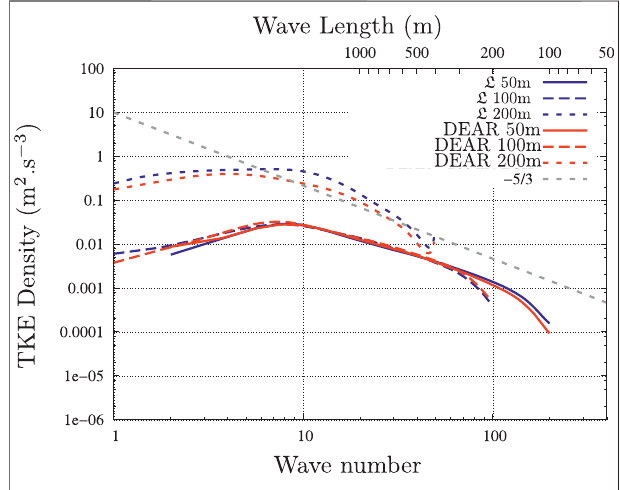
FIGURE 6 | IHOP horizontal TKE spectral analysis, inside the boundary layer and at 13 local hour of dynamics, for simulations undertaken with L DEAR (in red) and L (in blue) at 50, 100, and 200 m grid spacing. The gray dashed line is the Kolmogorov − 5 / 3 slope.